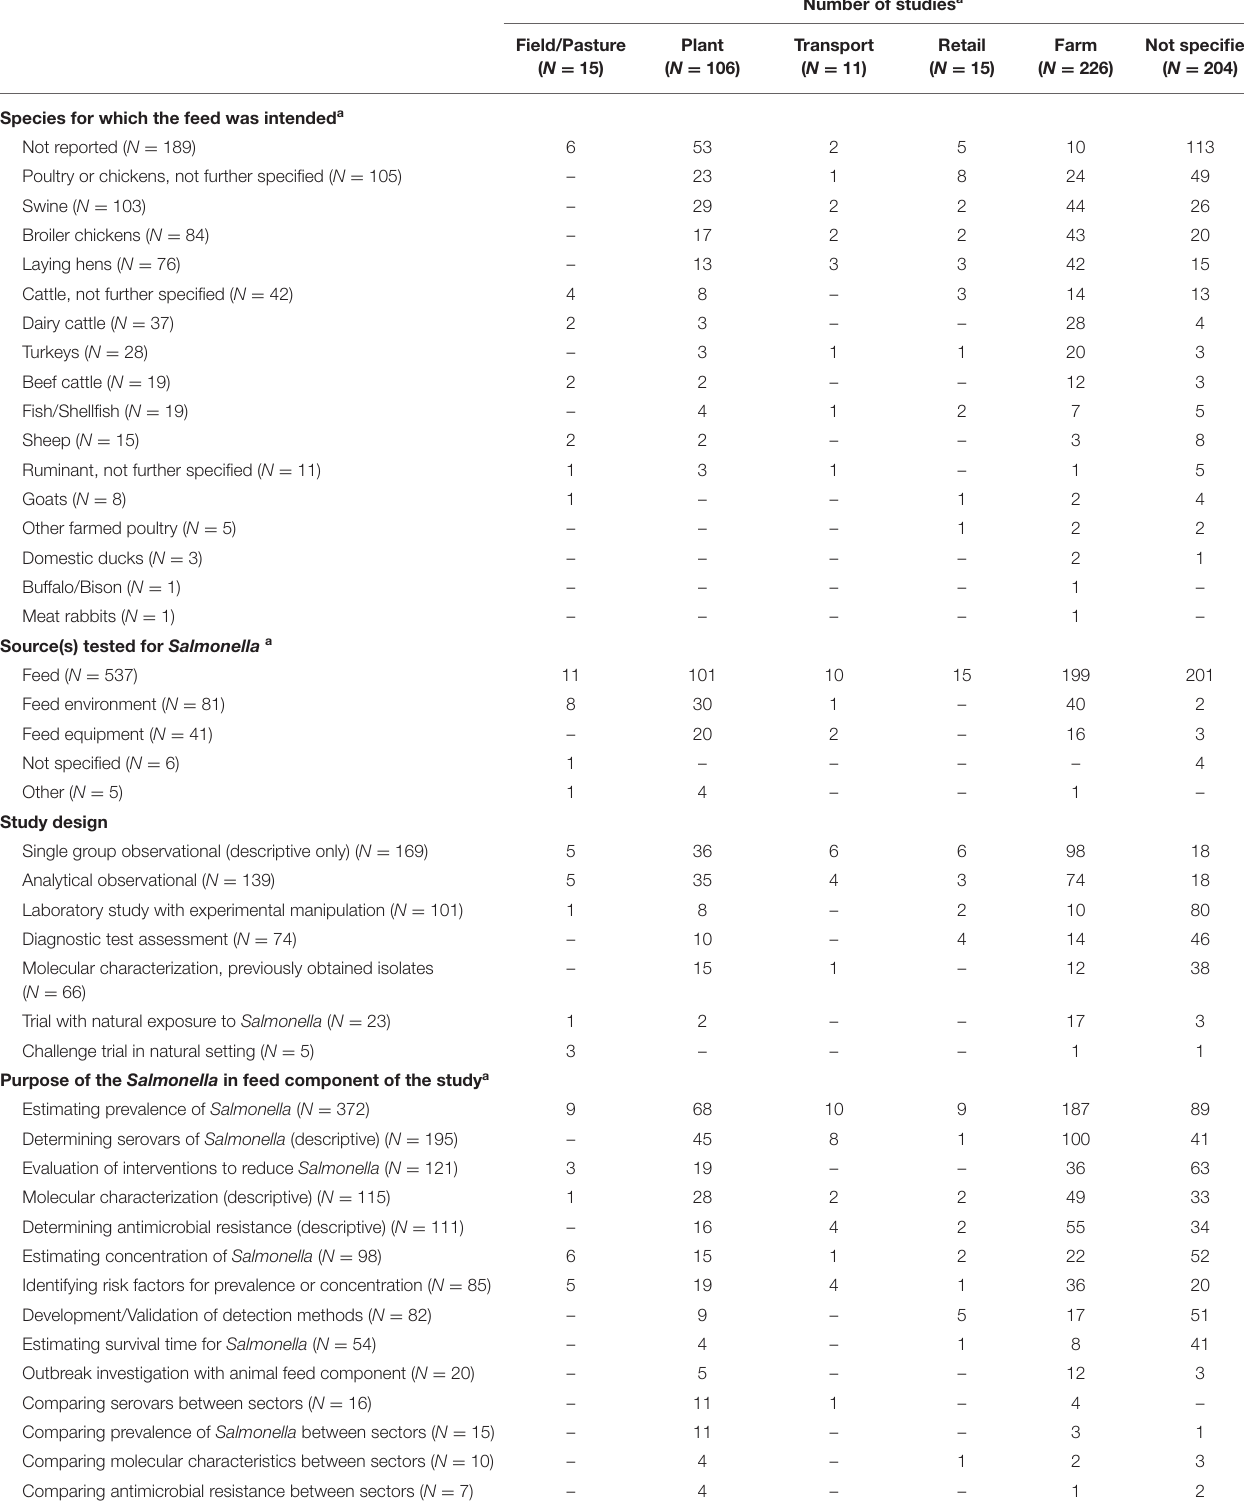
TABLE 2 | Summary of results for 547 studies investigating Salmonella in animal feeds by sector of animal feed